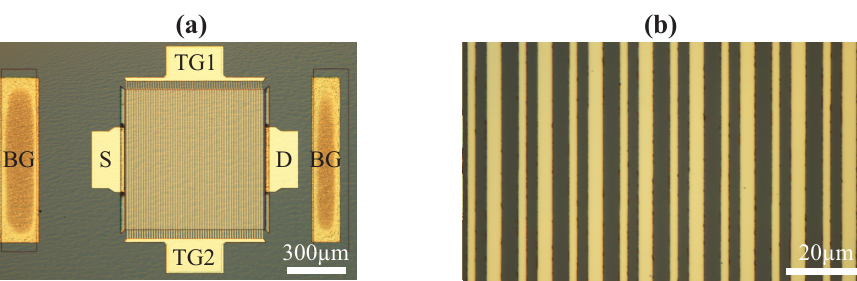
Figure 3. Optical microscope images of the fabricated large-area grating gate transistors ( a ) and close view of the gate structure ( b ).